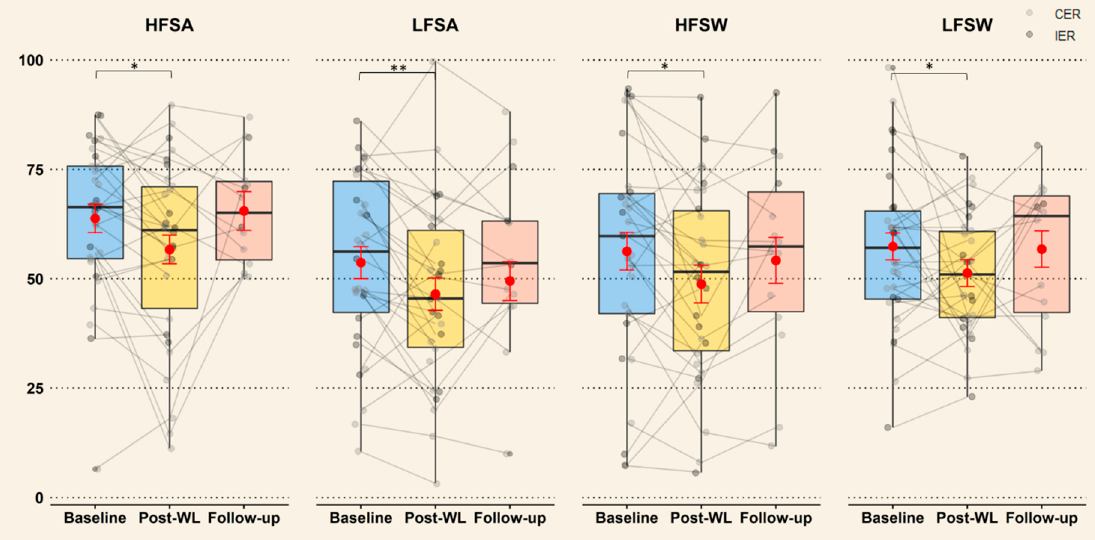
Figure 2. Change in liking for all food categories after ≥ 5% WL and 1-year follow-up ( n = 28). The individual data are represented by points (light grey for CER and dark grey for IER) and showed that there was no difference between diets. Estimated means from the mixed models are represented by red points with error bar (SE). Boxplots represent the variability of the data with the median (black line), interquartile range (colored box) and whiskers representing minimum/maximum (Q ± 1.5 x IQR). * Significant changes between baseline, post-WL and follow-up (* p < 0.05, ** p < 0.01), CER: continuous energy restriction, IER: intermittent energy restriction, HFSW: high-fat-sweet, HFSA: high-fat-savoury, LFSW: low-fat-sweet, LFSA: low-fat-savoury, WL: weight loss.